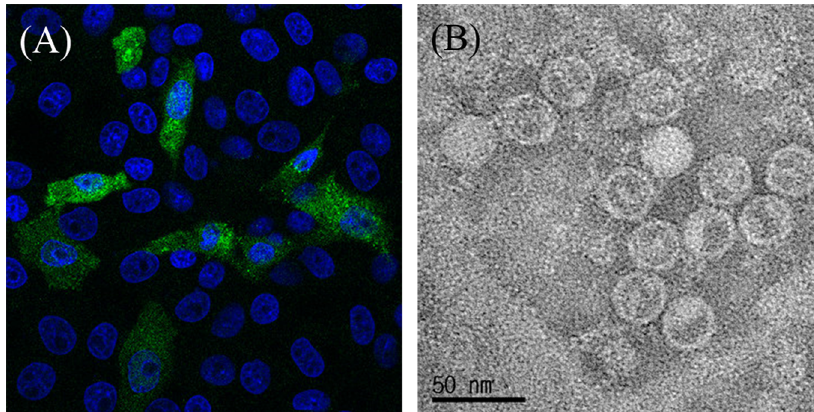
Figure 1. Identification and morphology of the porcine sapelovirus (PSV). (A) Immunofluorescence analysis of the PSV infected LLC-PK cells by laser confocal microscopy. The LLC-PK1 cells were incubated with mouse anti-153/5B5 monoclonal antibody, followed by staining with fluorescein-conjugated goat anti-mouse IgG antibody (green fluorescence). The nuclei were visualized by staining with DAPI (blue fluorescence). (B) Electron micrograph (EM) of cultured PSV strain KS05151. Virus pelleted by ultracentrifugation was stained with 1% phosphotungstic acid and sprayed onto coated EM grids.